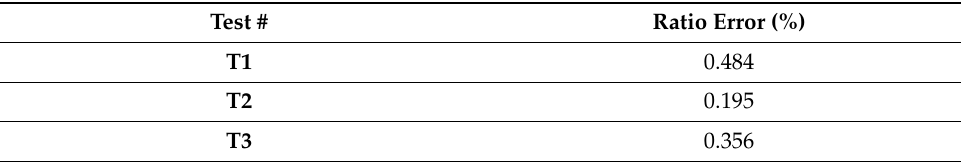
Table 3. Ratio error measurements results for each test.